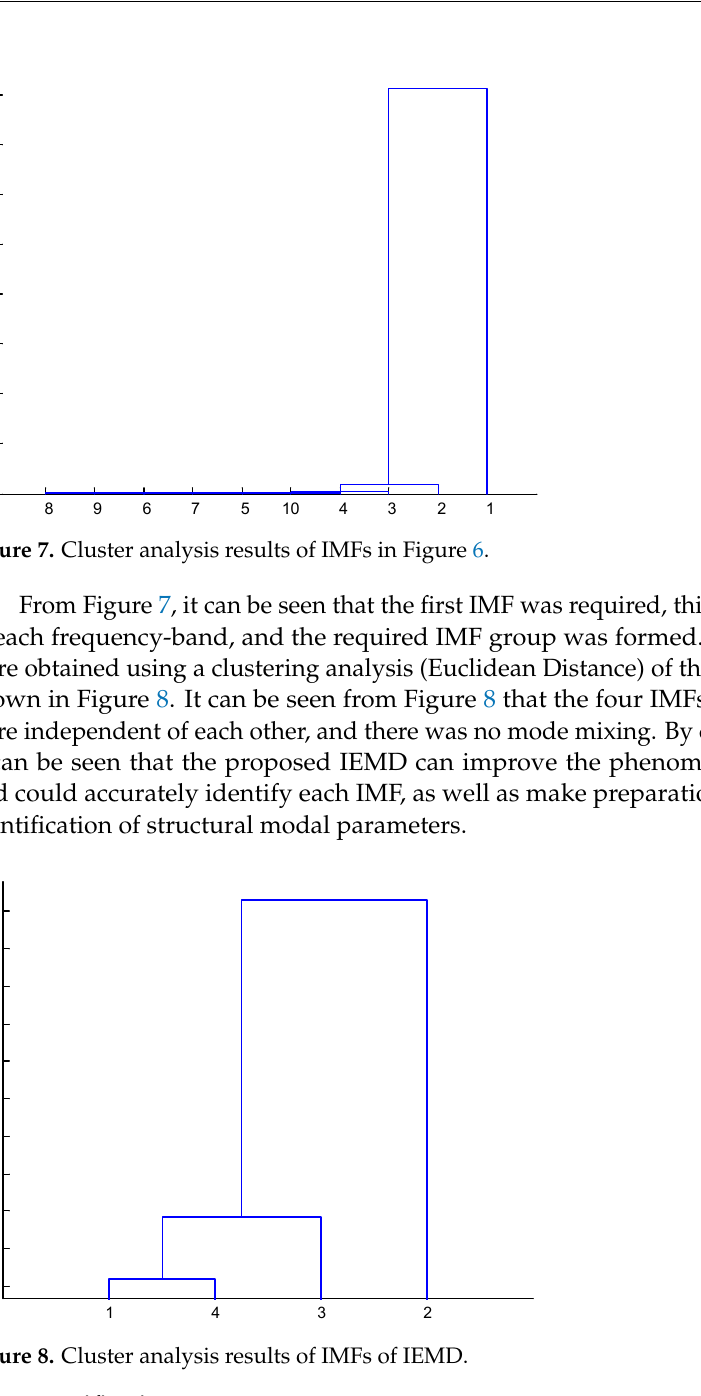
Table 1. Structural member characteristics.